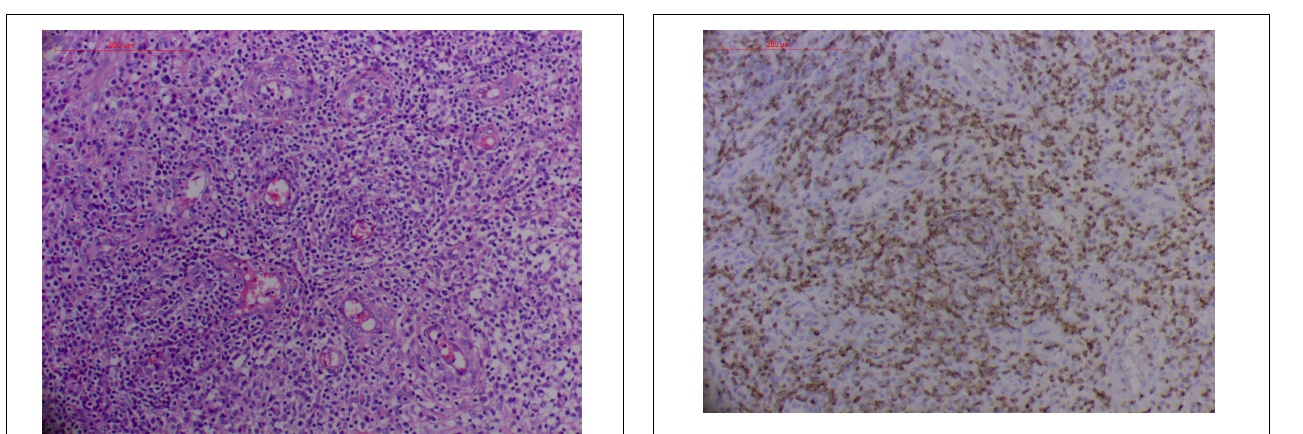
FIGURE 10 | Extranodal natural killer/T cell lymphoma, nasal type/rhino-orbital-cerebral mycosis.” Rhizopus arrhizus -induced positive expression of CD2 from granulomatous tissues (envision method, original magnification × 200).